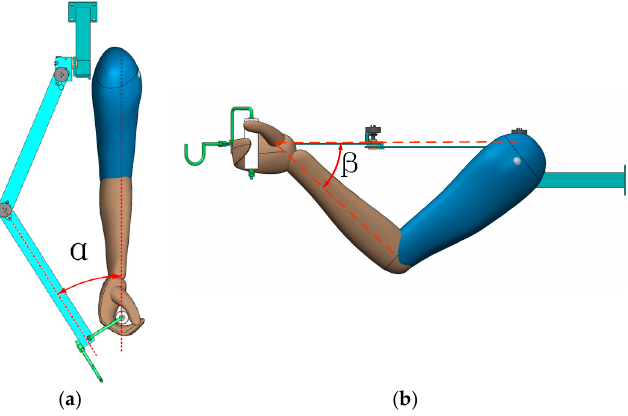
Figure 4. Working configuration of the 3 ‐ DOF upper ‐ limb exoskeleton. ( a ) Top view; and (b) right view In order for the 3 ‐ DOF upper ‐ limb exoskeleton to reach the workspace of the 5 ‐ DOF upper ‐ limb exoskeleton, the distance between the end ‐ effector and the shoulder should be the same as that of the 5 ‐ DOF upper ‐ limb exoskeleton. The lengths of the upper ‐ arm and forearm of the 5 ‐ DOF upper ‐ limb exoskeleton are 330 mm and 370 mm, respectively. In the sagittal plane of the shoulder joint, the distance between the end ‐ effector of the 5 ‐ DOF upper ‐ limb exoskeleton and the shoulder joint is shown in Figure 5a. In the sagittal plane of the shoulder joint, the distance between the end ‐ effector of the 3 ‐ DOF upper ‐ limb exoskeleton and the shoulder joint is described in Figure 5b. (cid:1841) (cid:2868) and (cid:1841) (cid:2869) represent the shoulder, (cid:1827) (cid:2868) and (cid:1827) (cid:2869) represent the elbow, (cid:1828) (cid:2868) and (cid:1828) (cid:2869) represent the end ‐ effector, (cid:2016) (cid:2868) and (cid:2016) (cid:2869) represent the angle between the upper ‐ arm and forearm, α represents the angle between the upper ‐ arm and the sagittal plane, (cid:1841) (cid:2868) (cid:1827) (cid:2868) and (cid:1841) (cid:2869) (cid:1827) (cid:2869) represent the upper ‐ arm, and (cid:1827) (cid:2868) (cid:1828) (cid:2868) and (cid:1827) (cid:2869) (cid:1828) (cid:2869) represent the forearm.